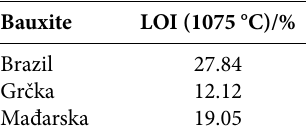
Table 2. Loss on ignition for bauxites from different deposits Bauxite LOI (1075 °C)/%